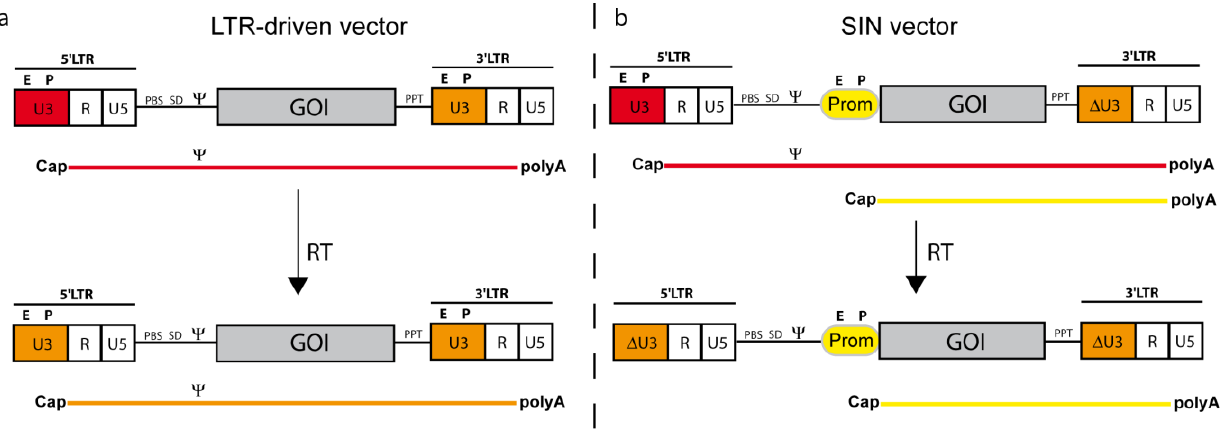
Figure 4. Schema of a gammaretroviral LTR-driven vector ( a ) and a SIN (self-inactivating) vector ( b ). The upper part shows the plasmid configurations along with the corresponding transcripts originating from either the internal promoter (Prom; b) and/or the LTR (a and b). The lower part depicts the vector architecture after reverse transcription (RT; i.e. , in the integrated form). Note that the promoter from the 3’LTR in the plasmid configuration is copied into the 5’LTR during reverse transcription facilitating the duplication of either SIN deleted U3 (  U3) or regular U3 promoter sequences. The corresponding RNAs (with Cap and polyA) are depicted under the vector diagrams (color codings indicating the appropriate